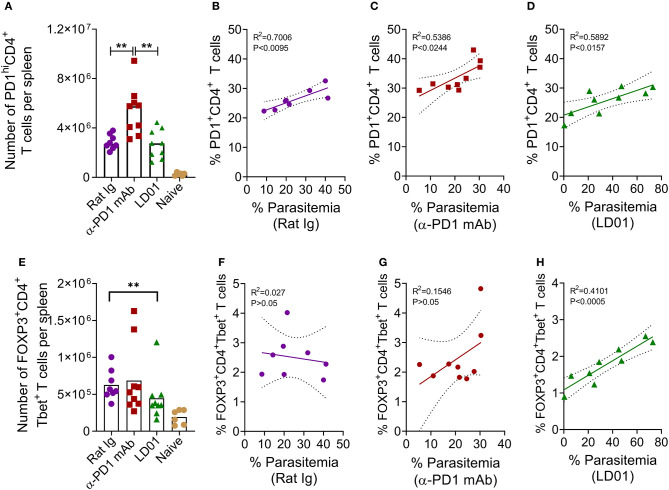
LD01 decreases the number of splenic FOXP3+Tbet+ CD4 T cells. 104 Py YM-infected red blood cells were injected IV into mice and treated IP with LD01 or antibody. Spleens from individual mice were harvested at day 6 post-infection, stained for CD3, CD4, CD8, Tbet, FOXP3, and PD1, and analyzed by flow cytometry. Spleens from naïve mice were used as controls. The numbers of PD1hiCD4+ T cells and FOXP3+Tbet+ CD4 T cells per spleen are shown in (A,E). Pooled data depict the mean of two independent experiments with n ≥ 3 mice per experiment. Significant differences were determined by Mann–Whitney test and are denoted by **p < 0.01. Parasitemia in each mouse infected with P. yoelii YM was graphed against the corresponding percentage of splenic PD1+CD4+ T cells (B–D) or the percentage of FOXP3+Tbet+ CD4 T cells (F–H). Representative dot plots for PD1, FOXP3 and Tbet staining are shown in Supplementary Figure.